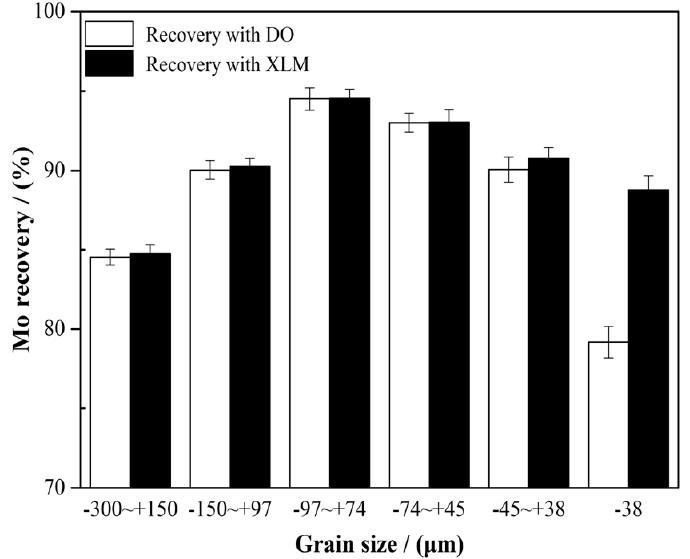
Figure 6. The flotation recovery of different size molybdenite particle in high calcium process water (pH = 8–9, Ca 2+ = 800 mg/L) from screening product of flotation test.